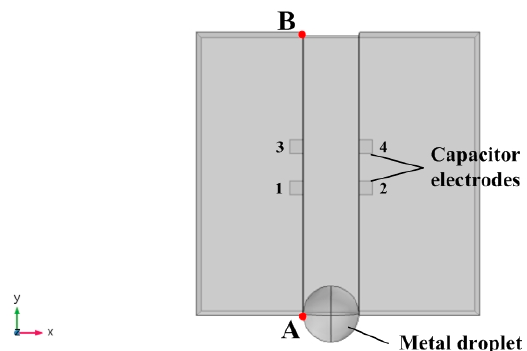
Figure 5. Schematic diagram of two pairs of capacitor electrodes.